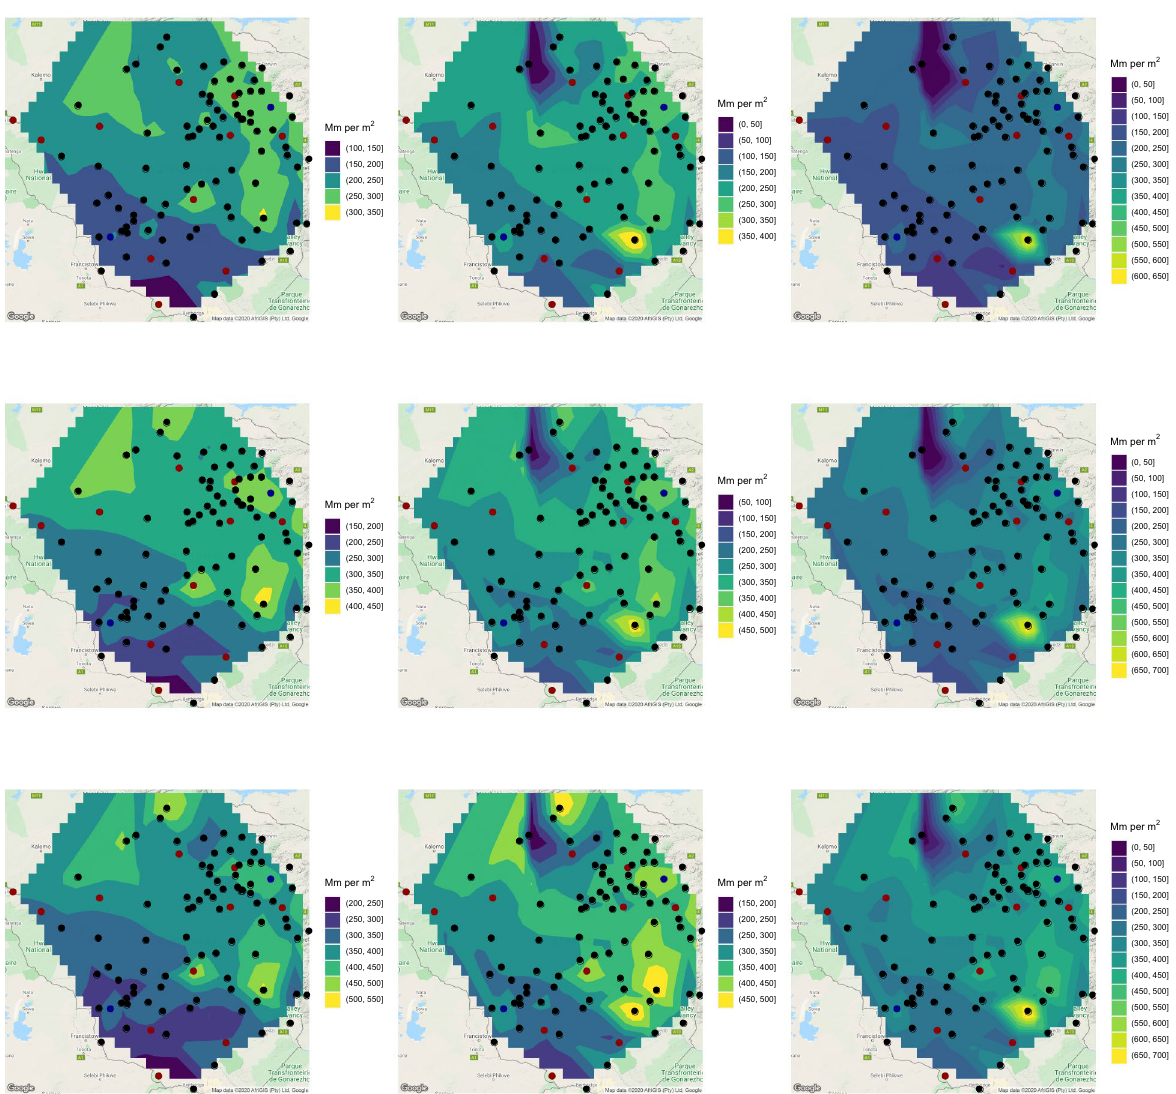
Figure 6. Estimates of 2-year return level (first raw, left), 2-year return level 10 years ahead (first raw, middle), 2-year return level 20 years ahead (first raw, right), 5-year return level (second raw, left), 5-year return level 10 years ahead (second raw, middle), 5-year return level 20 years ahead (second raw, right), 10-year return level (third raw, left), 10-year return level 10 years ahead (third raw, middle) and 10-year return level 20 years ahead (third raw, right). ggplot2 version 3.3.5, https:// cran.r- proje ct. org/ web/ packa ges/ ggplo t2/ index. html was used for